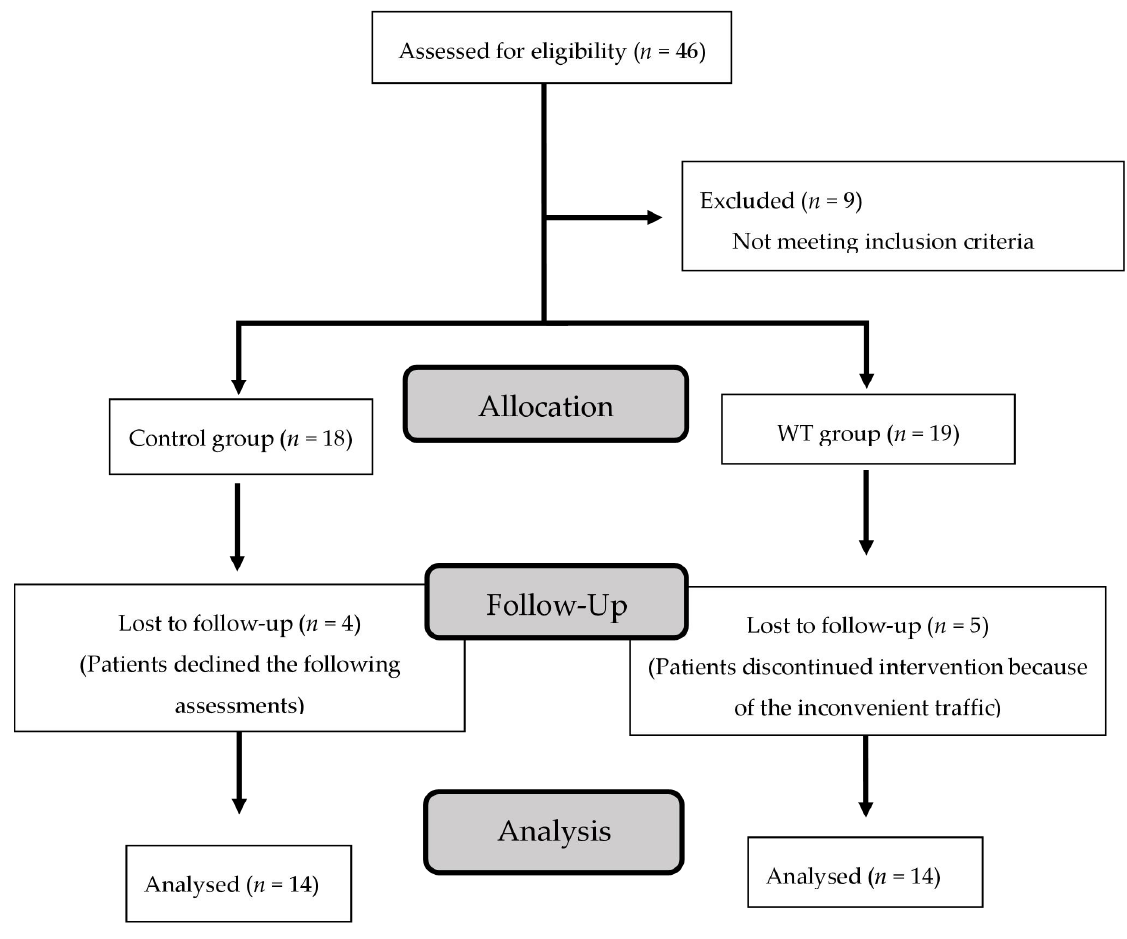
Figure 1. Flowchart of patient enrollment.